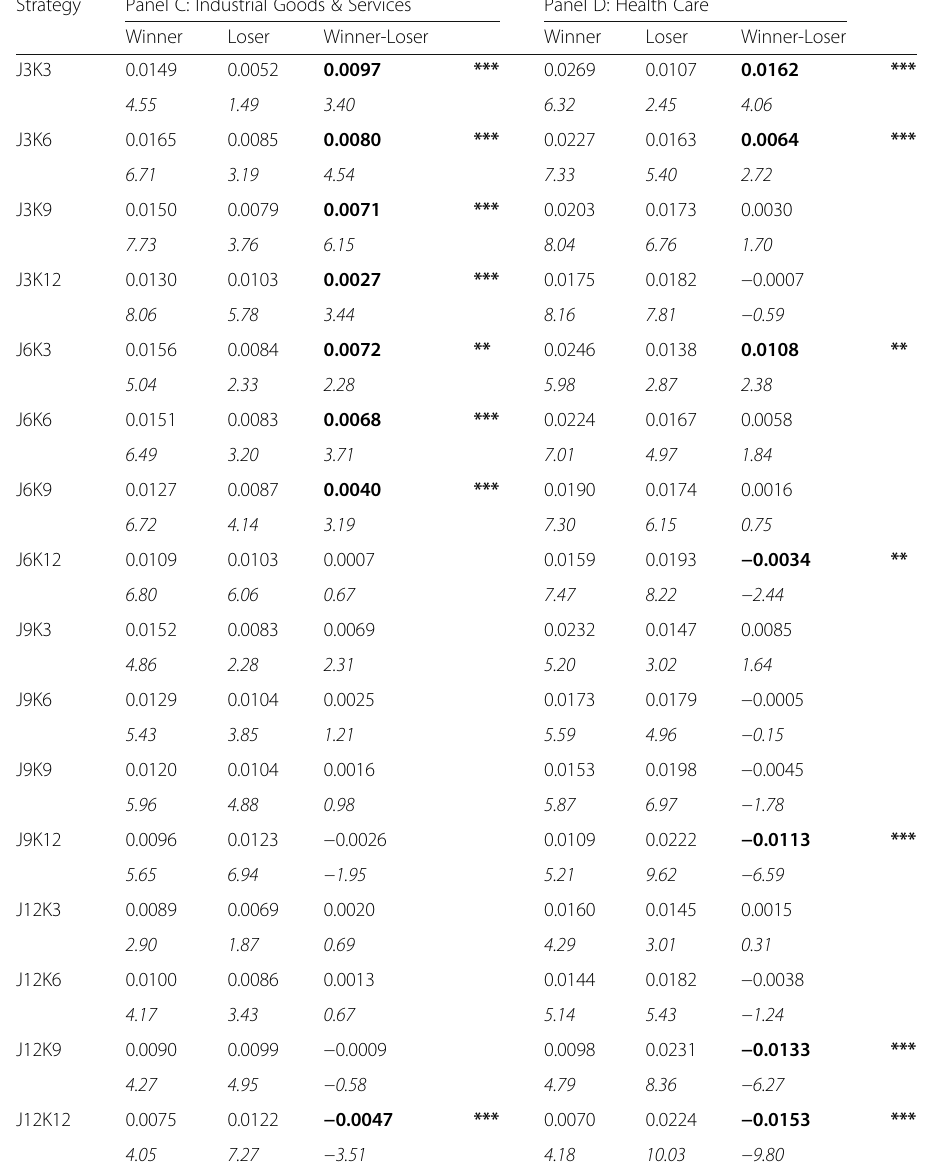
Table 5 (Part II). Industry-Neutral Momentum Portfolios